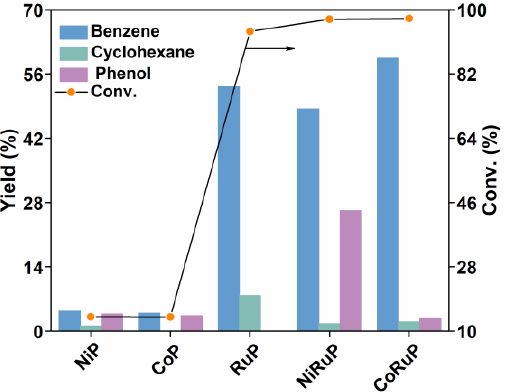
Figure 6. Depolymerization of diphenyl ether over different metal phosphides.